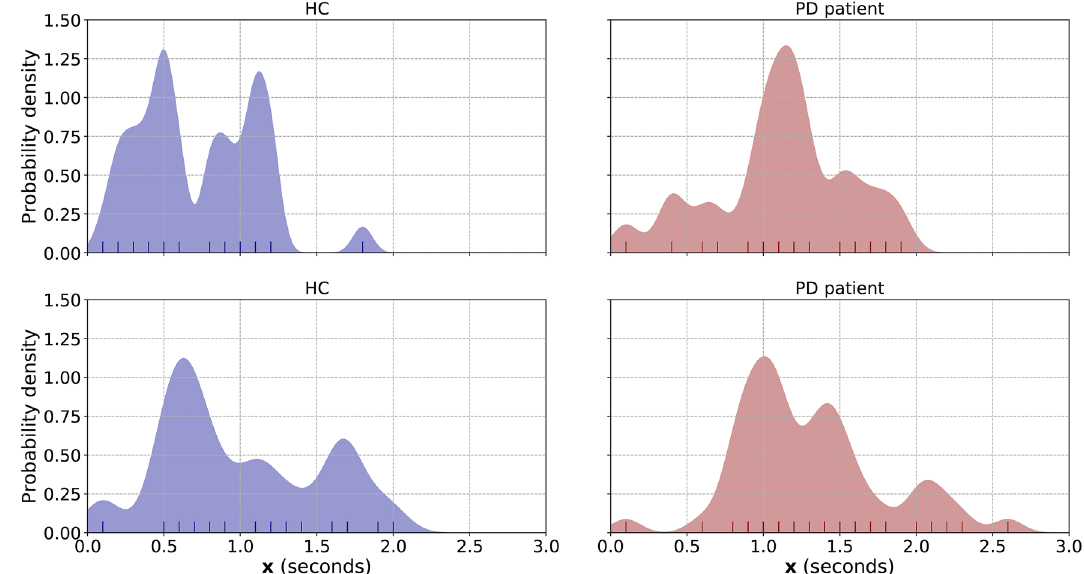
Figure 3. Figure depicting the subject level representations x f for two HC (left column, blue) and two PD patients (right column, red). The vertical lines at the bottom of each figure denote the elements of x (all PtM durations from every meal of the participant) that where used to estimate the PDF in each case. Finally, the calculated bandwidths ˆ h x for the HC are 0.064 (top) and 0.120 (bottom), while for the PD patients are 0.092 (top) and 0.095